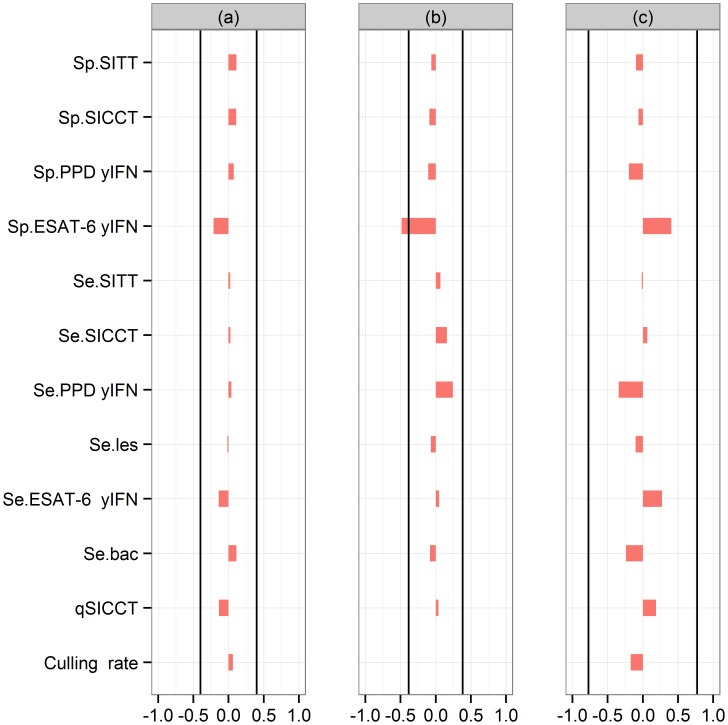
Impact of changes of fixed parameter values on the estimates of α, βinside and βoutside.(a): relative error for α; (b): relative error for βinside; (c): relative error for βoutside; black line: value of the coefficient of variation of the posterior distributions obtained when we using the default values of fixed parameters; if the relative error value is within the two black lines, the effect of fixed parameters values on parameter estimates in the model is considered limited; qSICCT: percentage of SITT-negative animals tested 6 weeks after by SICCT; see table 2 for the definition of the other parameters.